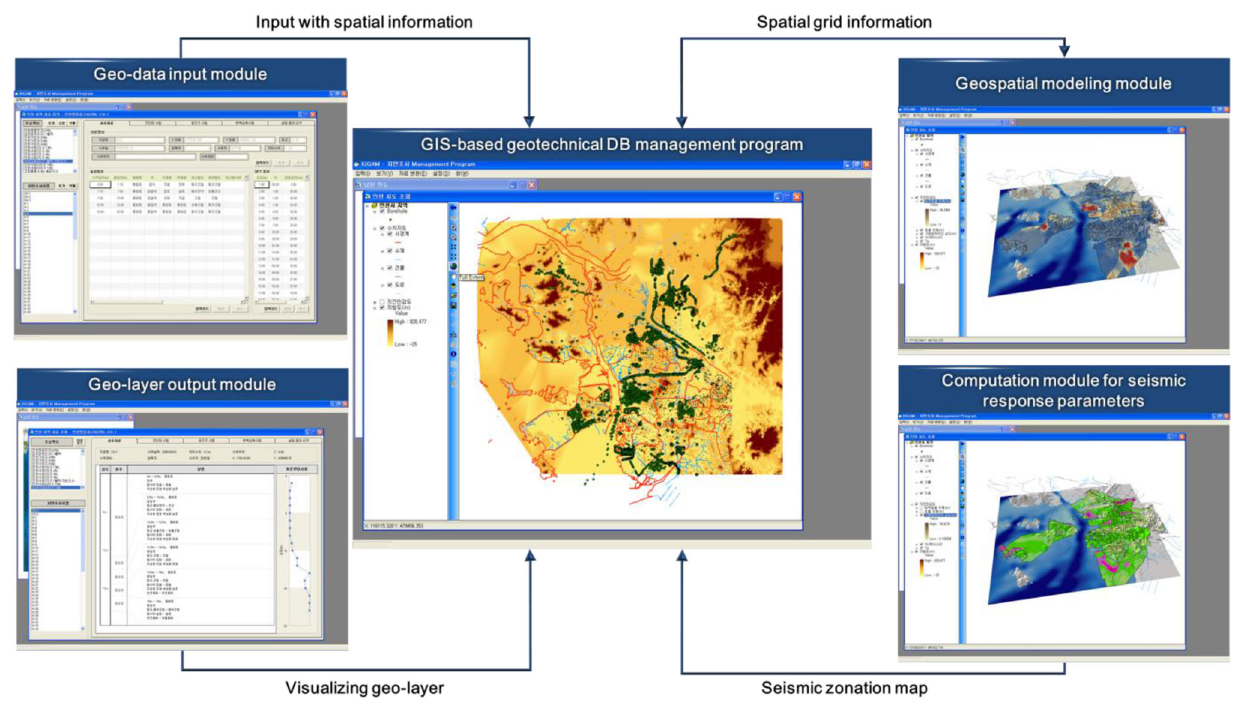
Fig. 4 Management program with geo-data for the study area in South Korea. DB